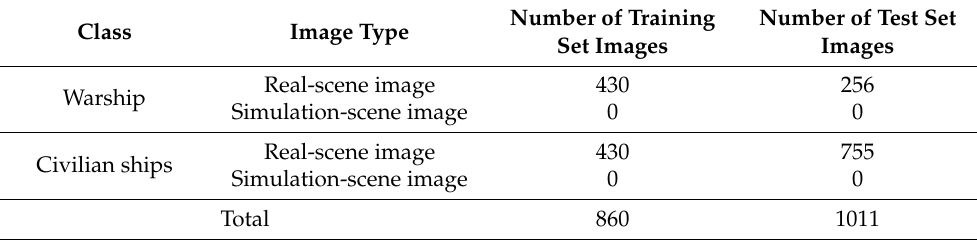
Table 1. Setting of the real-scene ship